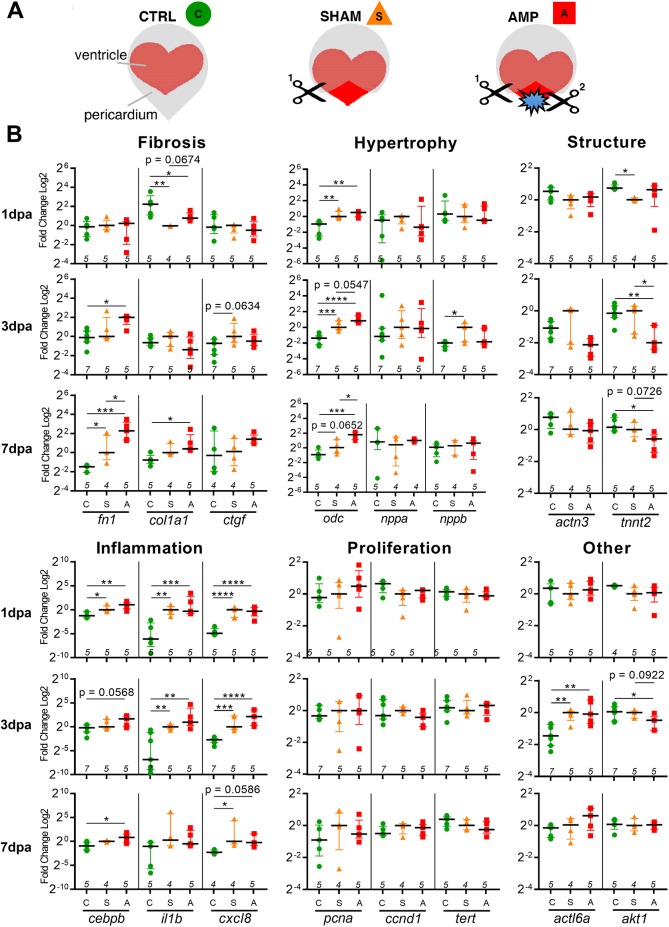
Short-term transcriptional responses in adult frog heart after cardiac injury display evidence of a scarring process.(A) Heart ventricles from different experimental conditions were collected for RT-qPCR analysis: control non-operated hearts (CTRL), SHAM-operated hearts where only the pericardium was opened (scissor 1, SHAM), and amputated hearts where a ventricle biopsy was performed following pericardium opening (scissor 1 & 2, AMP). (B) RNA extraction was performed on whole heart ventricles, collected at days 1, 3 and 7 post-amputation followed by RT qPCR to quantify gene expression. Gene markers of fibrosis (fn1, col1a1, ctgf), hypertrophy (odc, nppa, nppb), cellular structure (actn3, tnnt2), proliferation (pcna, ccnd1, tert), inflammation (cebpb, il1b, cxcl8), actl6a and akt1 were monitored. Aligned dot plot with median and interquartile range, n≥4 for each group with exact n displayed above the x-axis. Normalisation was performed using the geometric mean of two reference genes (smarcd1/smn2), fold-change is shown in log2 scale, respective to SHAM for each gene at each individual time-point. *, p < 0.05, **, p < 0.01, ***, p < 0.001, ****, p < 0.0001.